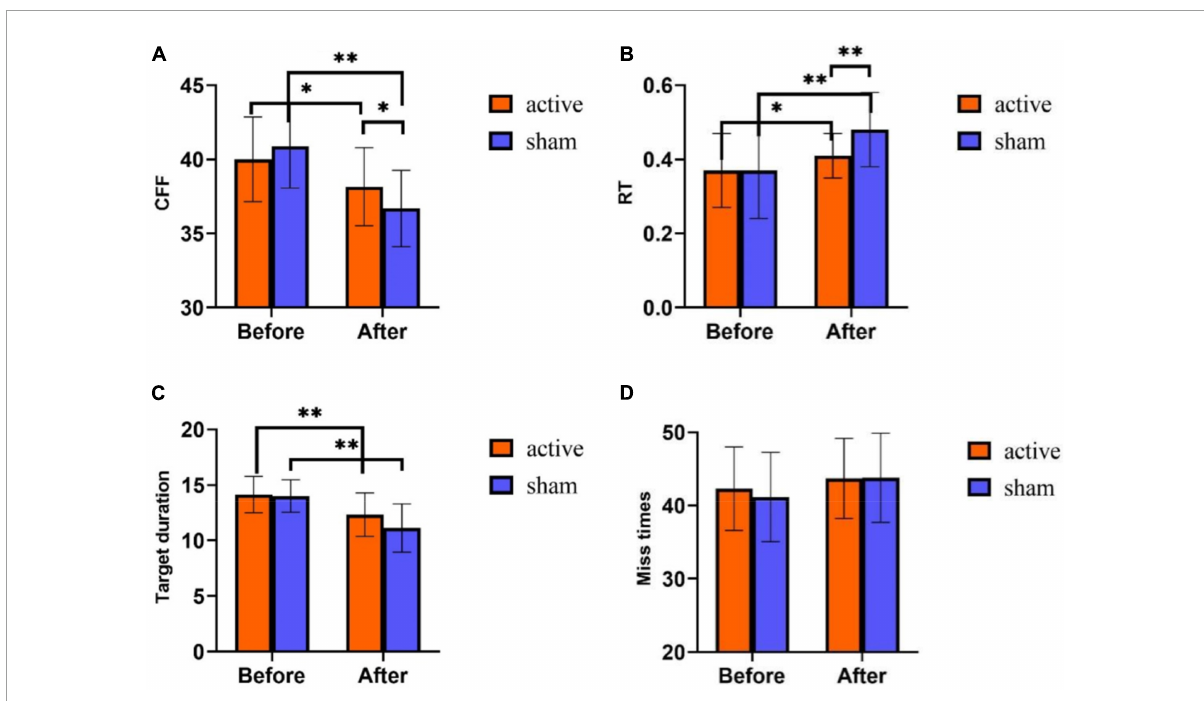
FIGURE4 Behavior test results of tPCS on athletic mental fatigue. (A) Critical flicker frequency (CFF); (B) reaction time (RT); (C) target duration (attention); (D) miss times. ∗ p < 0.05, ∗∗ p < 0.01.